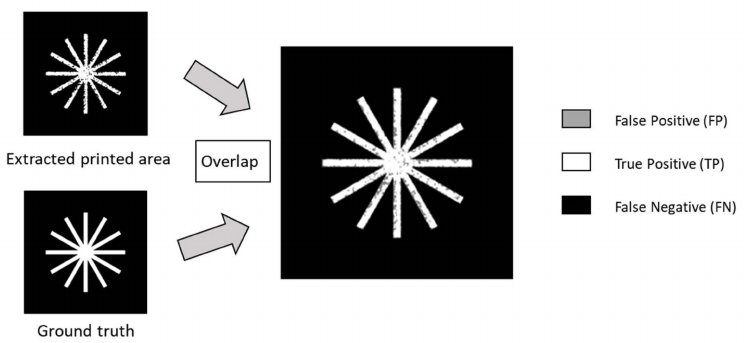
Figure 5. Calculation scenario of F1